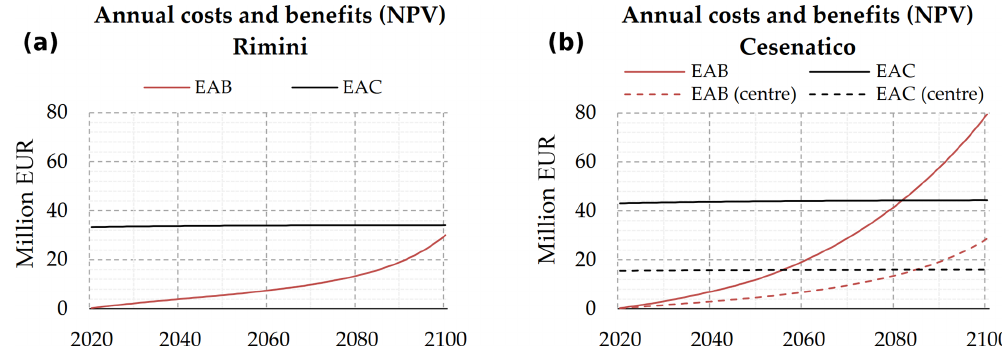
Figure 11. Cumulated flood defence costs and expected benefits at the net present value for Rimini (a) and Cesenatico (b) .